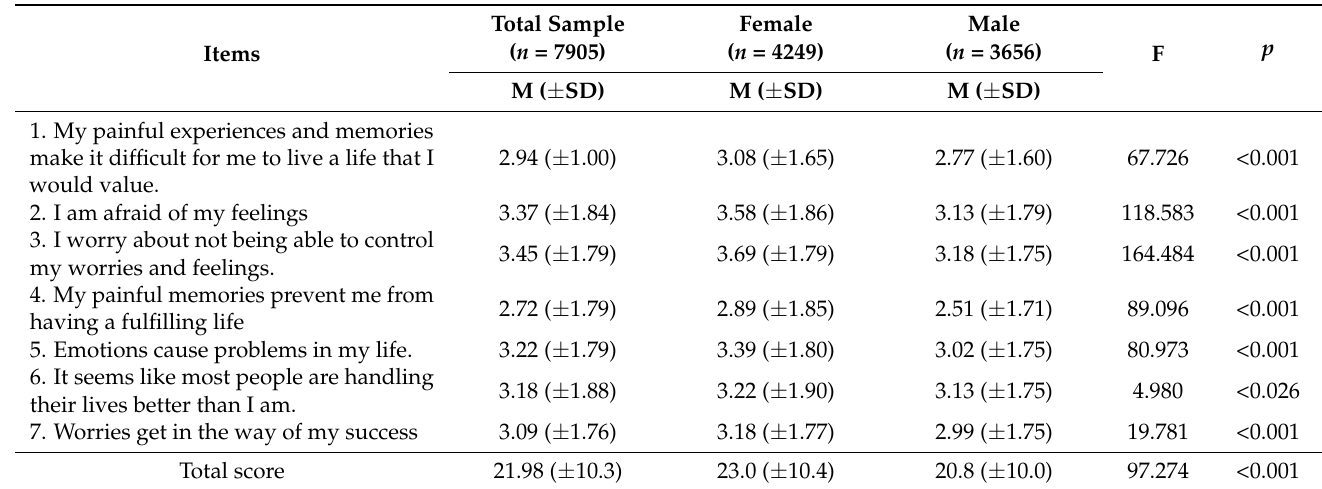
Table 1. Sex differences in AAQ-II scores.